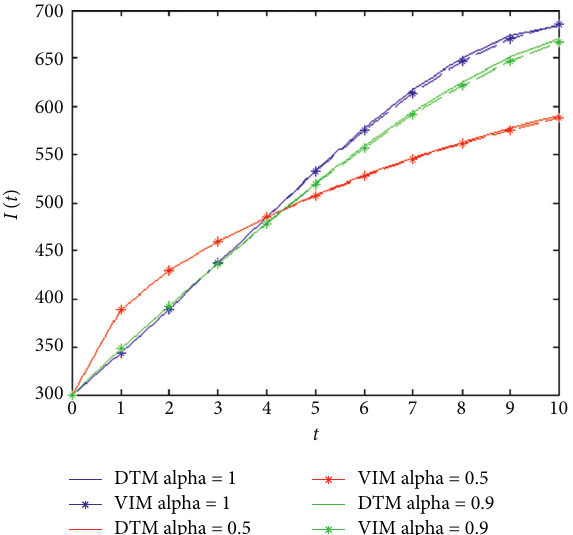
Figure 2: Comparison of VIM solutions with the CDTM solutions of I ( t ) for system (10) at different α .